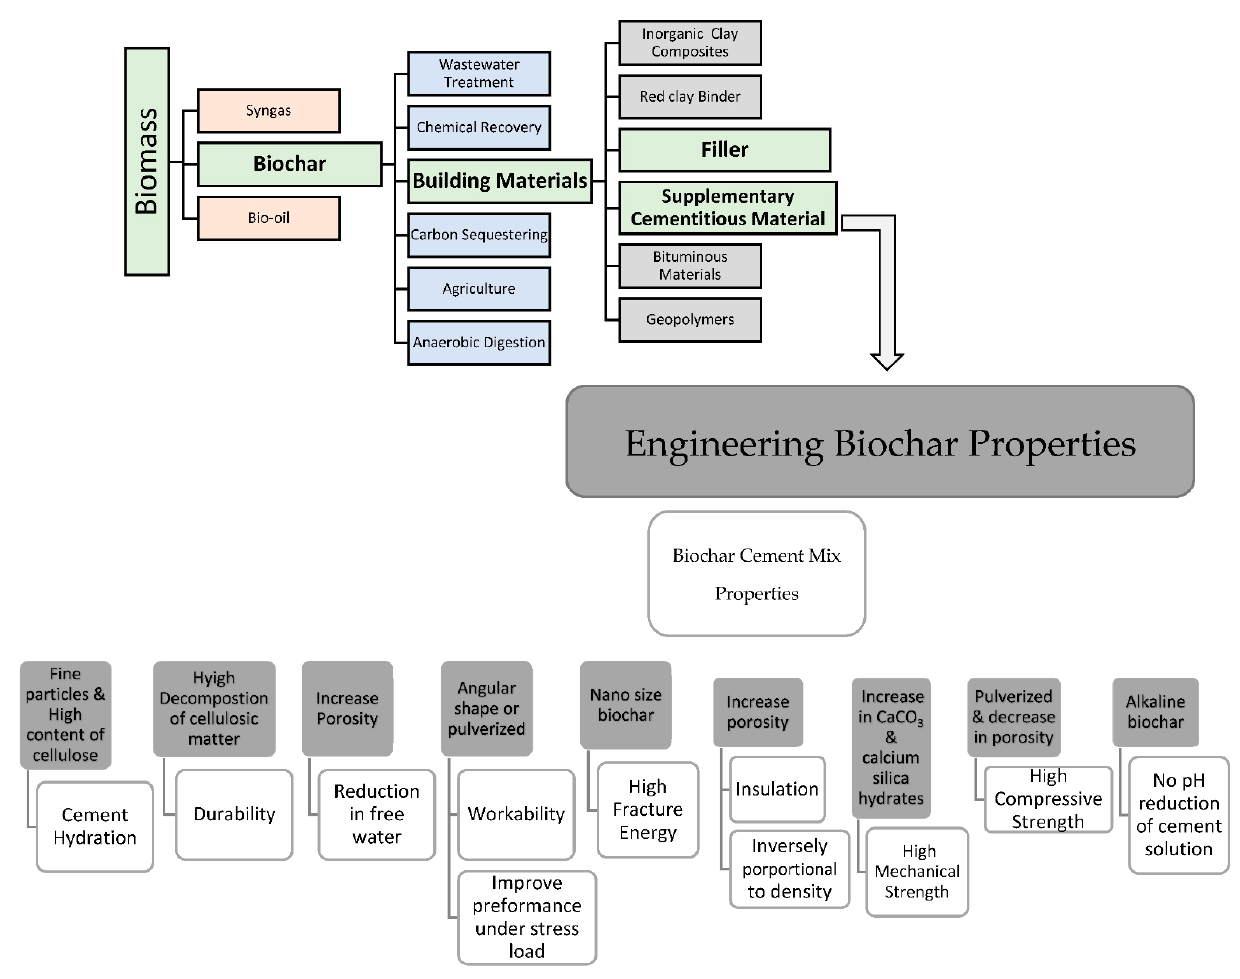
Figure 3. Breakdown of the process of biochar production from the source (biomass) to product